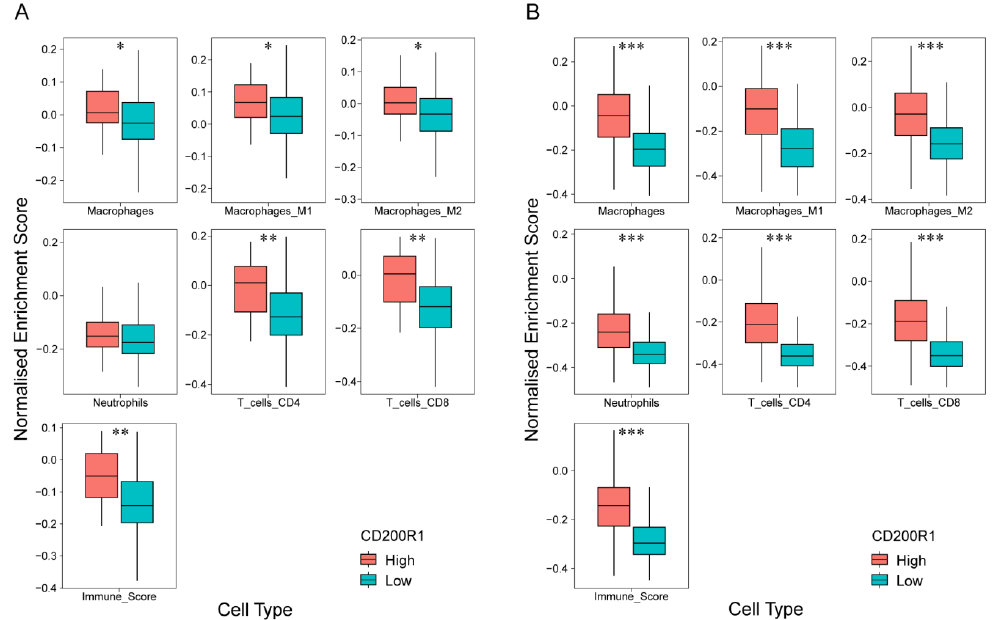
Figure 5. Boxplots of immune cell gene scores (normalized enrichment scores) stratified based on CD200R1 mRNA expression in the GEO ( A ) and TCGA ( B ) datasets using ConsensusTME analysis. ( A ) * p < 0.001, ** p < 1 × 10e − 5 ; ( B ) *** p < 2 × 10e − 16 .